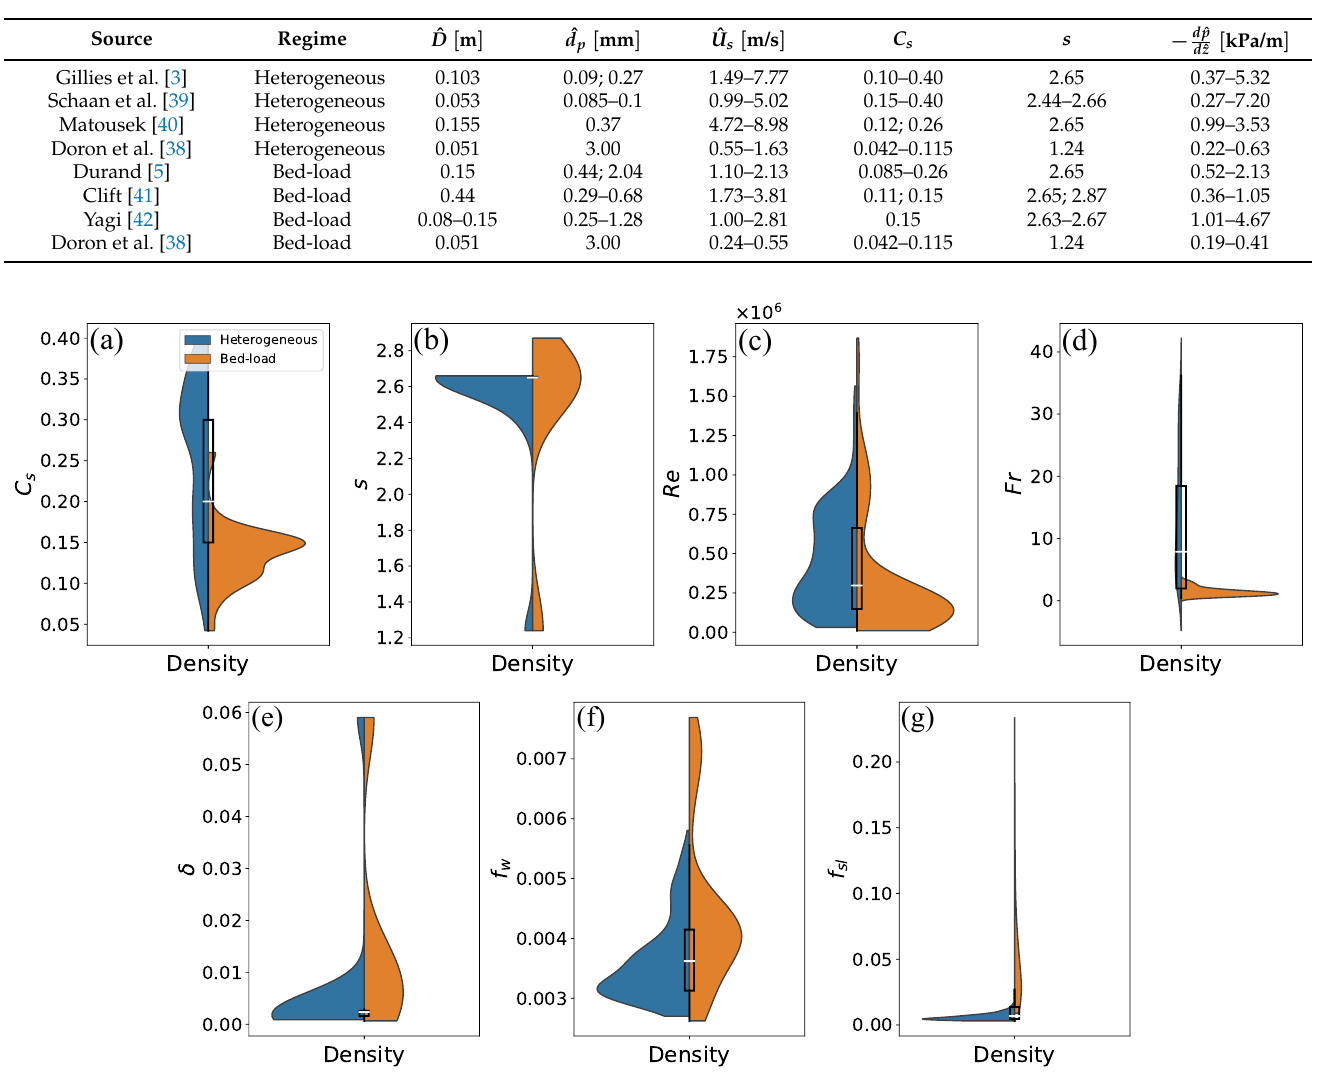
Table 4. Parameters of the experimental data considered for comparison for frictional pressure drop.